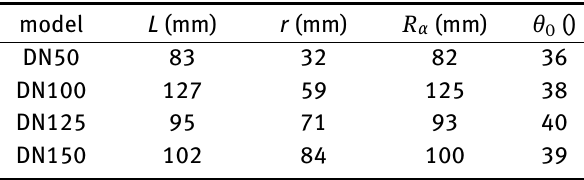
Table 1: Parameters of the tested rubber pipes.